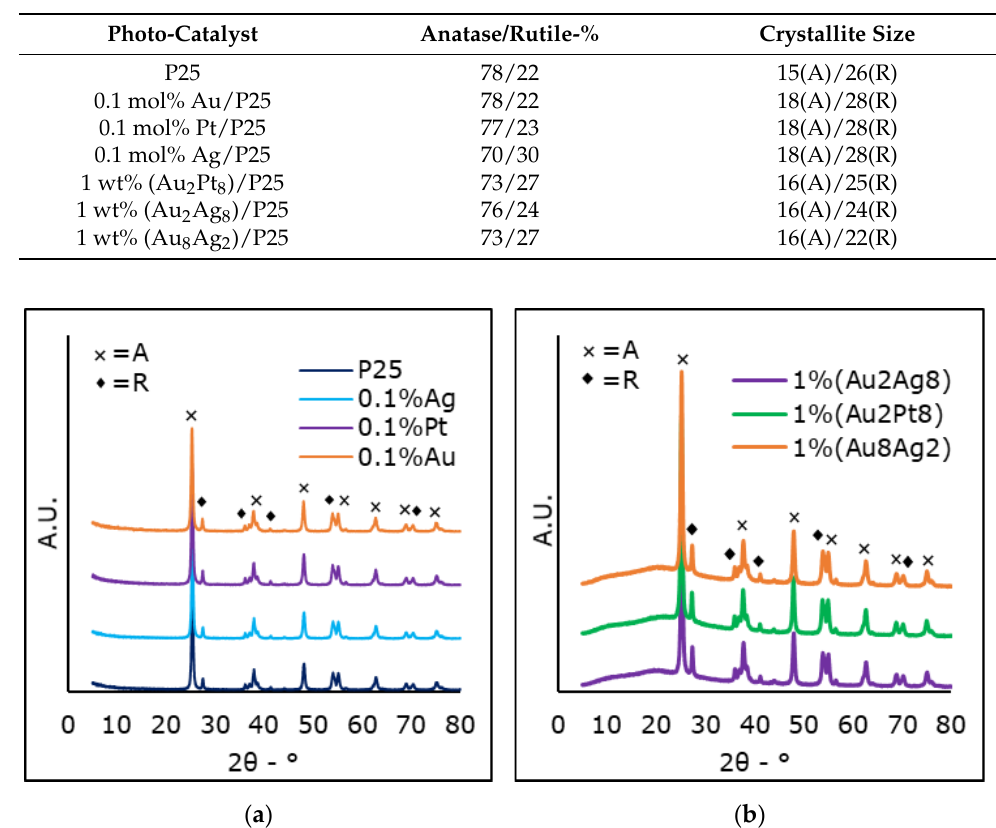
Figure 5. XRD spectra of bare P25 compared with ( a ) mono and ( b ) selected bi − metallic photo- catalysts. “A” stands for Anatase and “R” refers to Rutile .